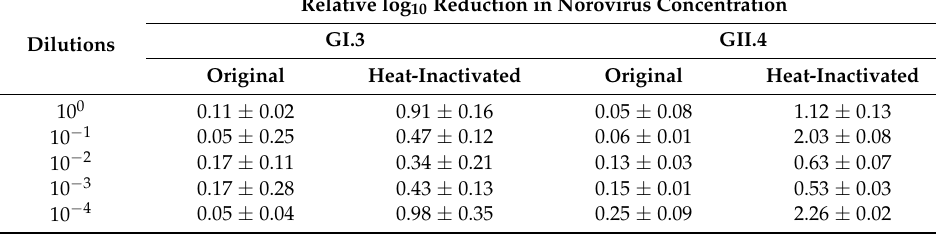
Table 1. Relative log 10 reduction (mean and standard deviation) of norovirus GI.3 and GII.4 concentrations in original (non-heat-inactivated) and heat-inactivated suspensions after PEMAX TM treatment. Relative log 10 Reduction in Norovirus Concentration GI.3 GII.4 Dilutions Original